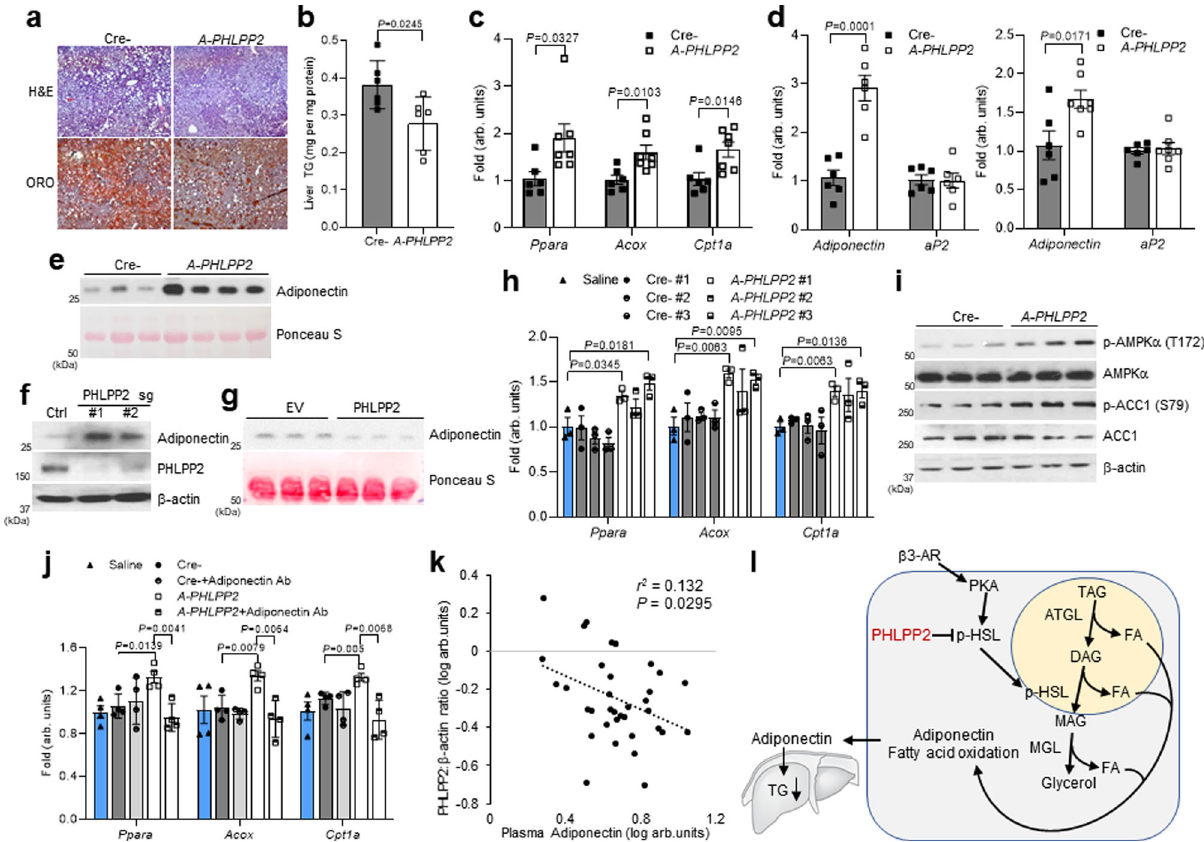
Fig. 6 Blocking adipocyte PHLPP2 protects from diet-induced fatty liver. a – c H&E and oil-red O (ORO) staining (Scale bars, 100 μ m) ( a ), TG ( b ), and gene expression ( c ) from livers of HFD-fed Cre- and A-PHLPP2 mice ( n = 6 – 7 independent mice per group). d, e Adipoq and aP2 gene expression in eWAT (left) or iWAT (right) ( d ), and representative serum adiponectin ( e ) from HFD-fed Cre- and A-PHLPP2 mice ( n = 6 – 7 independent mice per